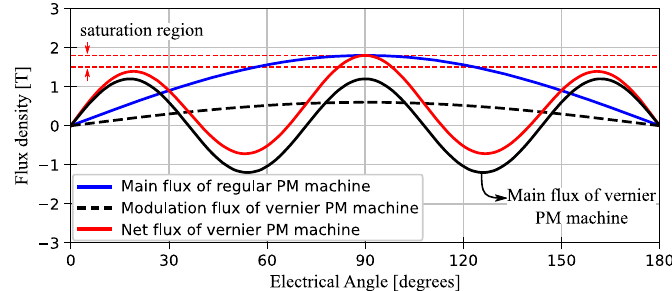
Figure 2. Conceptual distribution of the flux density.